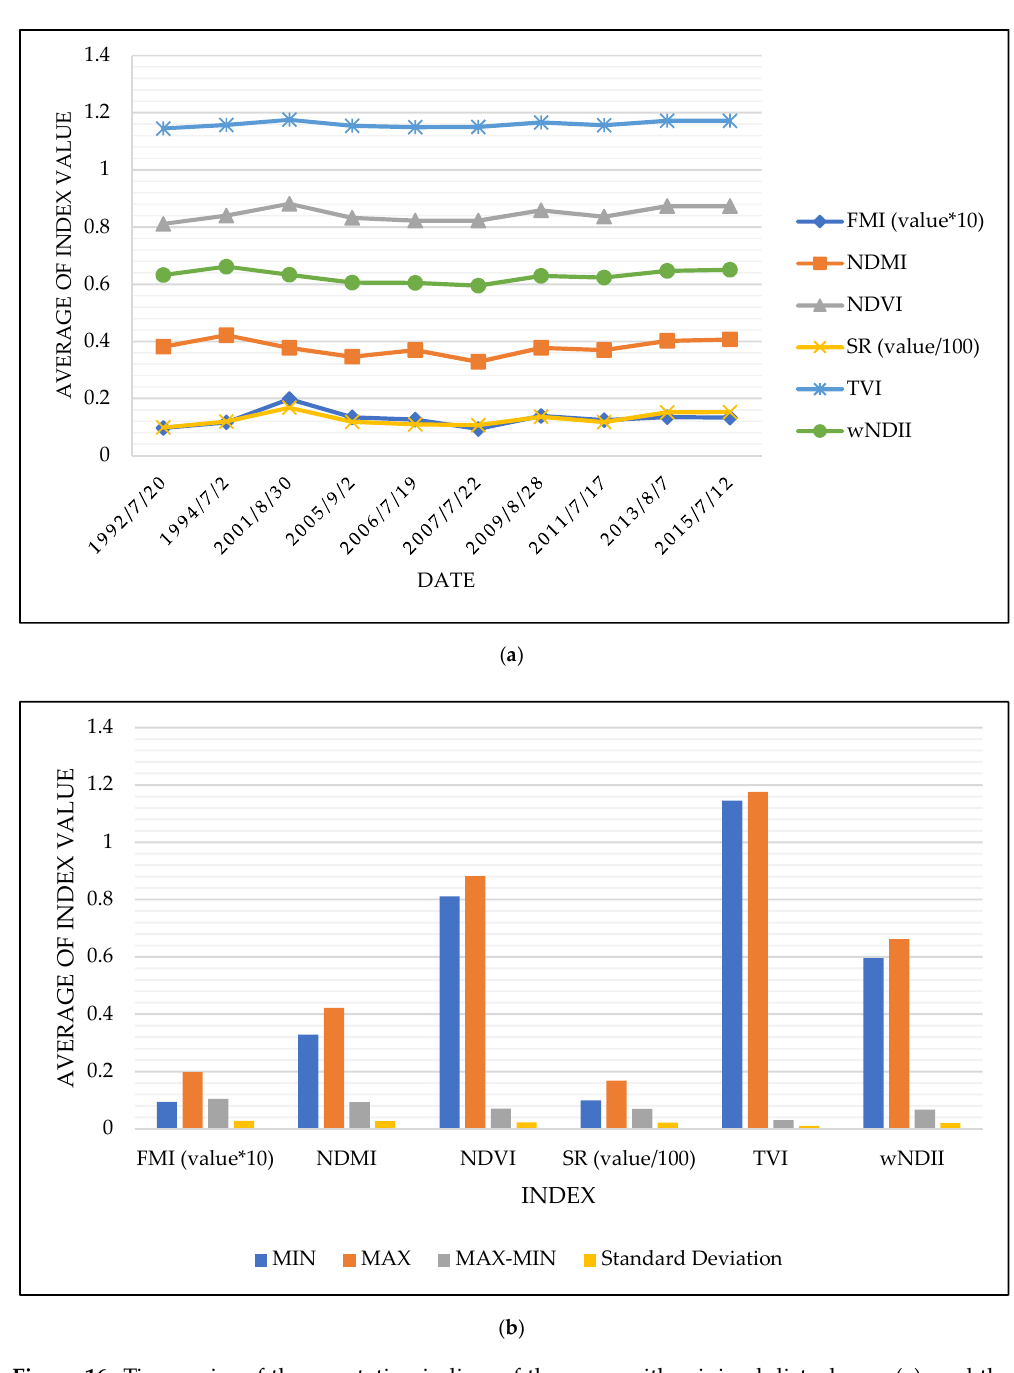
Figure 16. Time series of the vegetation indices of the areas with minimal disturbance ( a ); and the statistical information ( b ) (the average from the Low Tatras National Park) (Source: Own work). Table 6. Statistical information about the average values in the disturbed areas in the Low Tatras